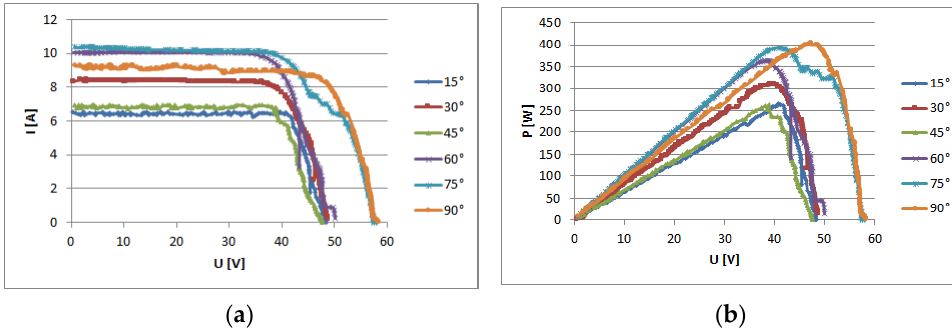
Figure 9. The bifacial module’s characteristics—measurements for the foil substrate: ( a ) current- voltage characteristics; ( b ) power-voltage characteristics. Table 8. Results of measurements and calculations for a foil